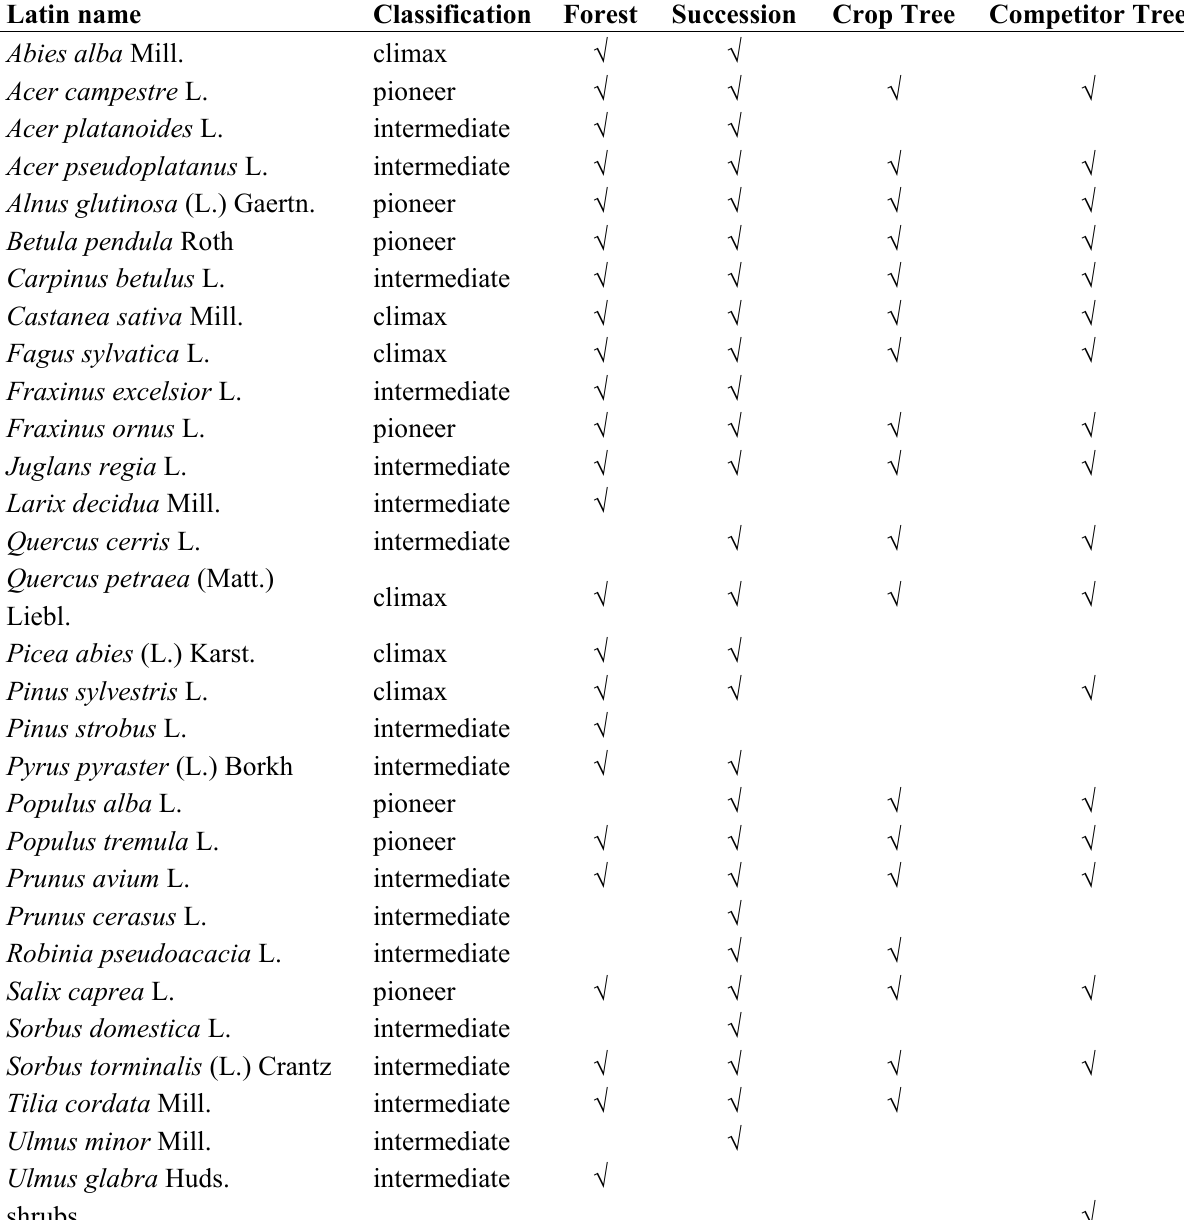
Table A2. A list of observed tree species indicating which species were selected as crop or competitor trees, and their classification as pioneer, intermediate or climax species.